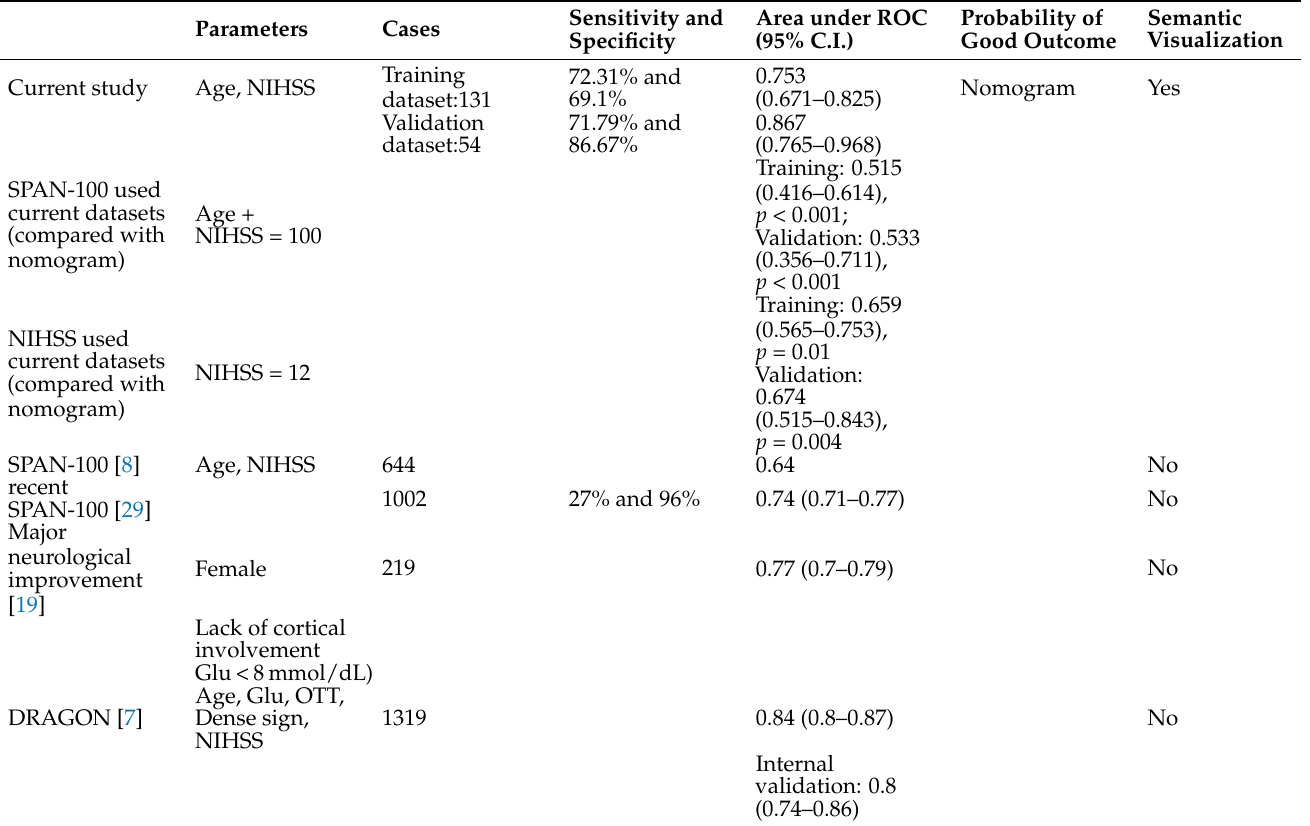
Figure 5. Decision curve analysis of the training dataset. Table 4. The performance of this study and comparison with the related studies. The performance of Stroke Prognostication using Age and NIH Stroke Scale (SPAN)-100 index and the threshold NIHSS score of 12 used training and validation compared with the current